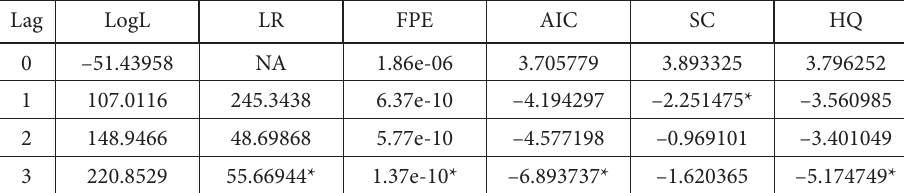
Table 3. VAR lag order selection